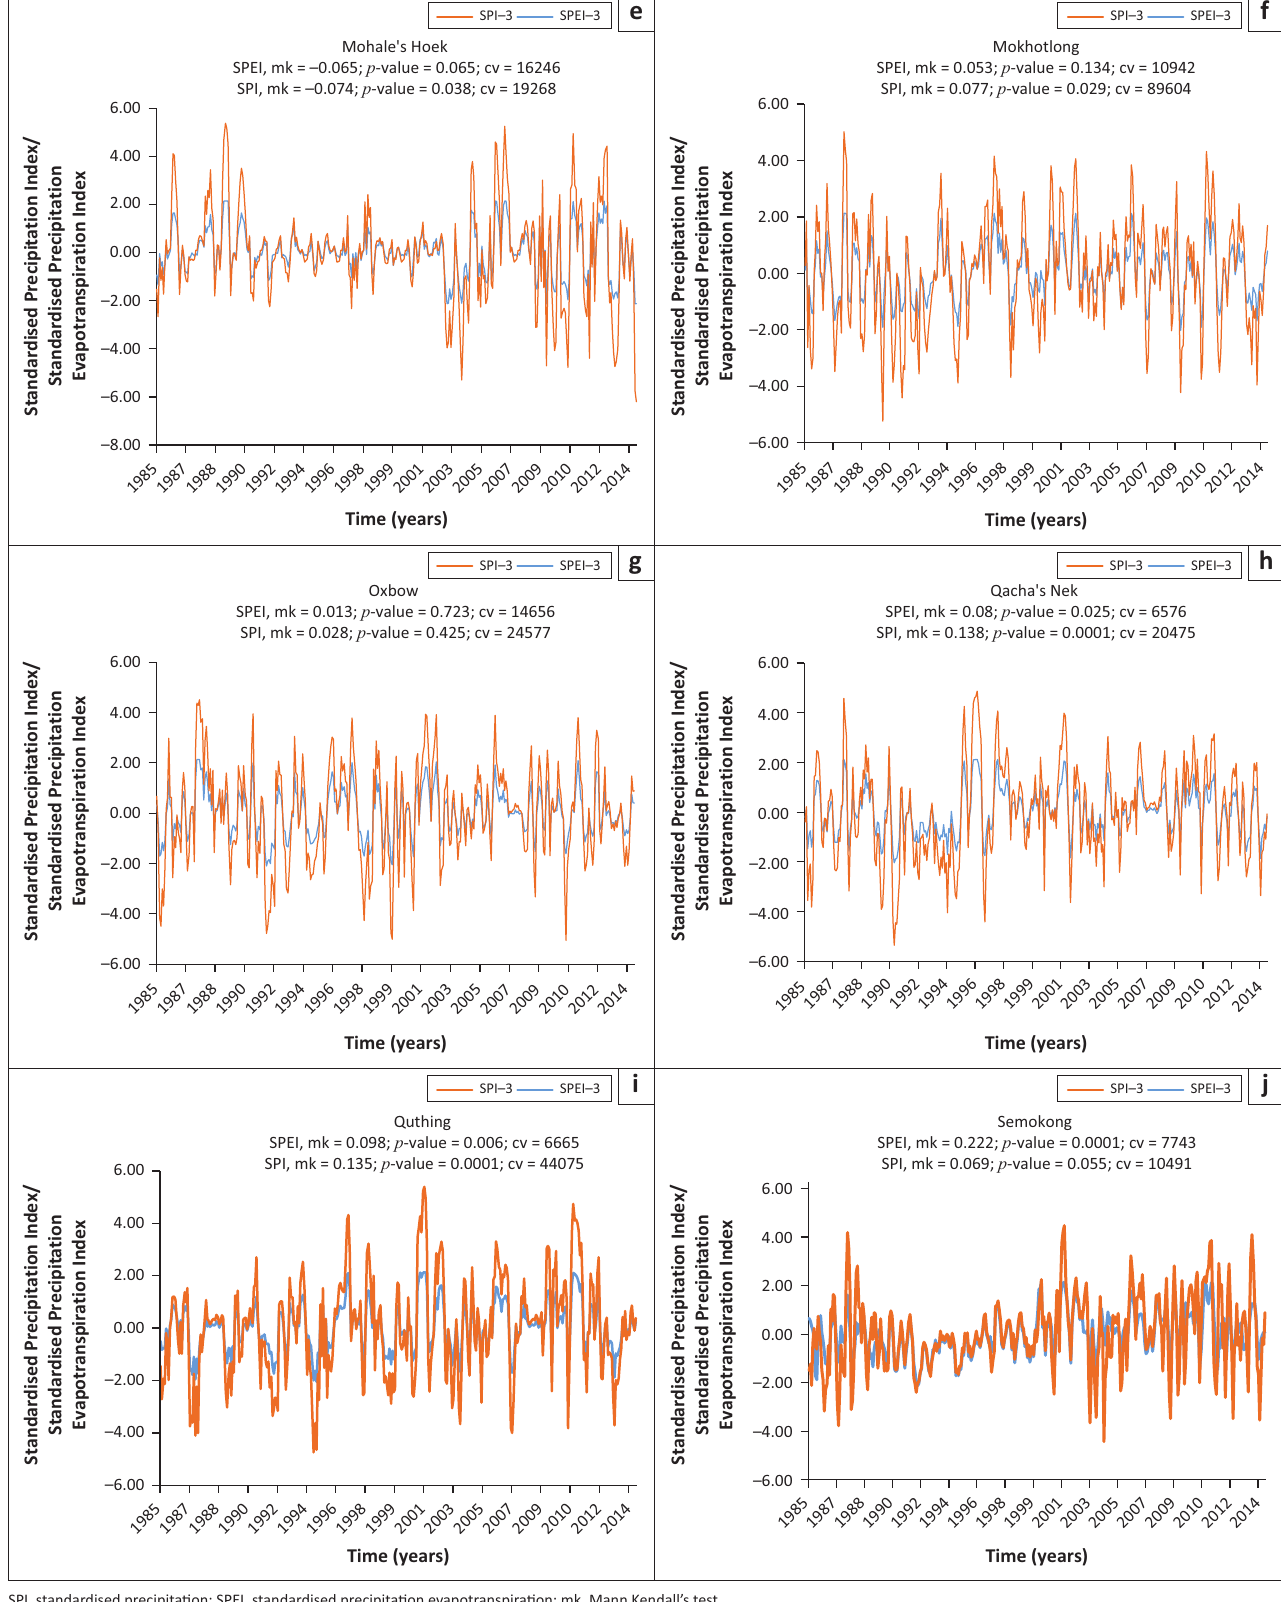
SPI, standardised precipitation; SPEI, standardised precipitation evapotranspiration; mk, Mann Kendall’s test. FIGURE 2 (Continues...): Standardised precipitation/standardised precipitation evapotranspiration-3